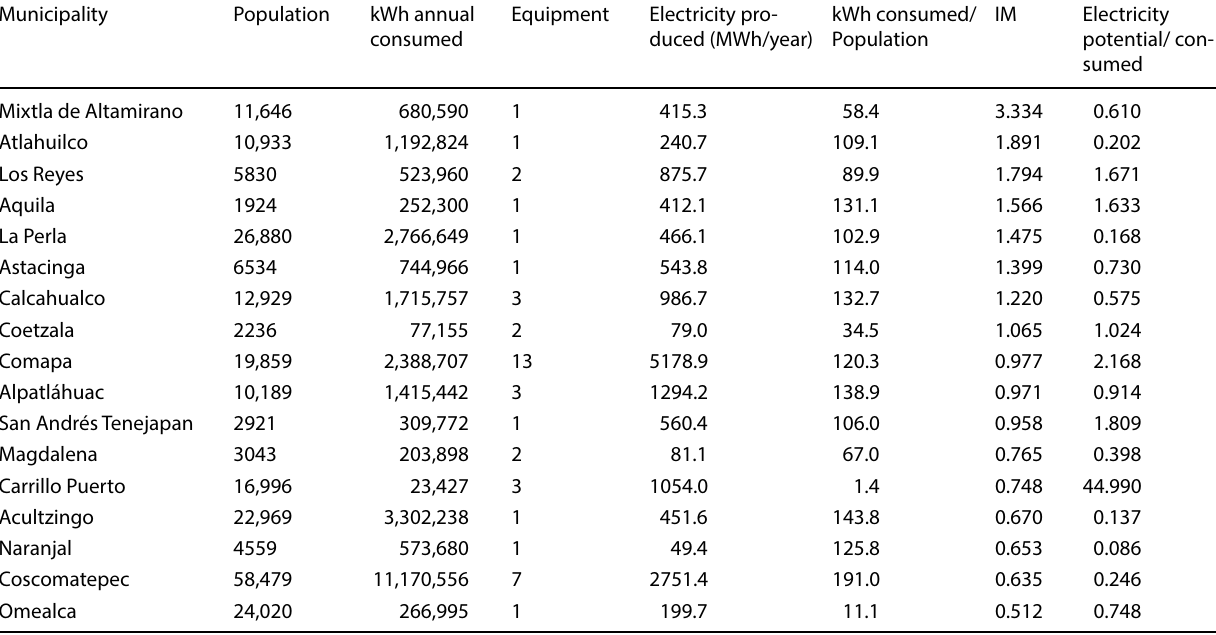
Table 9 Extract for Veracruz state, municipalities sample Municipality